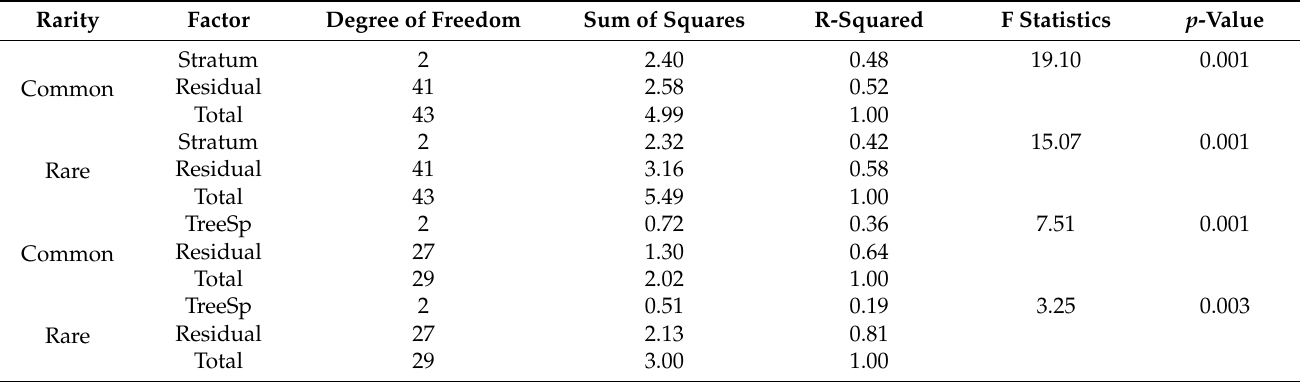
Figure 3. NMDS plot demonstrating the influence of strata on the overall beta diversity for common beetle species ( a ) and only the rare beetle species ( b ), according to the red list categories. NG—near- ground stratum, LC—lower canopy, UC—upper canopy. Table 1. PERMANOVA quantification of the impact of different environmental sources of variation on the dissimilarities between